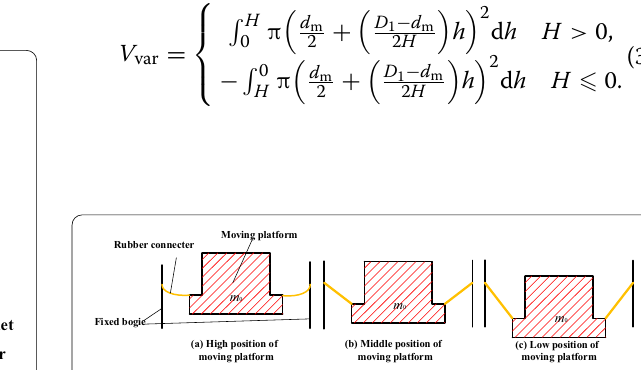
Figure 1 Structure of the pneumatic spring Figure 2 The change of the moving